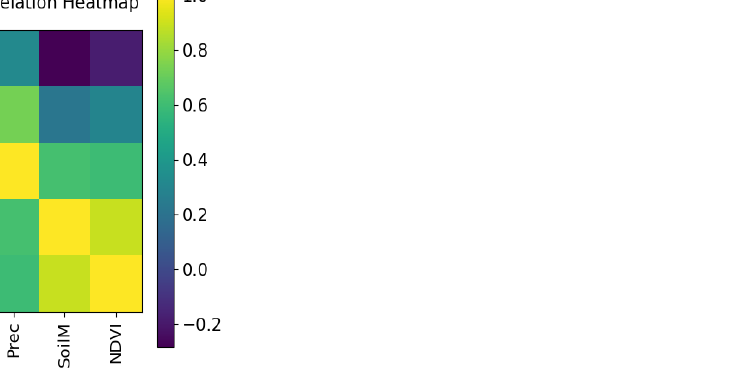
Figure 8. Mufindi district correlation heatmap based on data from 2002/2003 to 2009/2010 maize